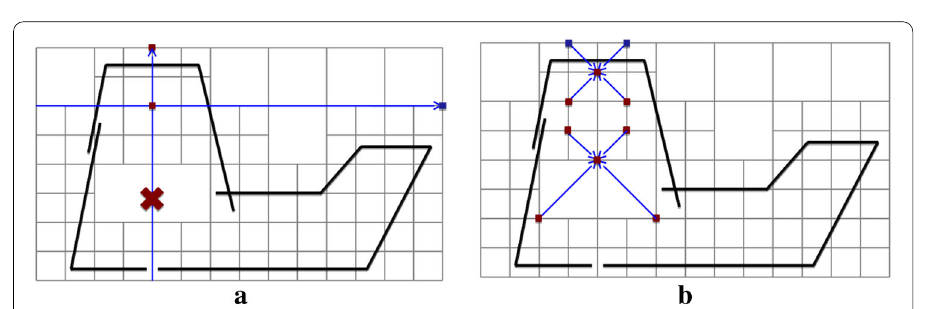
Fig. 31 Concept of voting: two rays vote whether a certain node is inside or outside. Then a decision is made based on the votes. Here, one ray is voting for outside and the other for inside. Note that in 3D, there is one more ray, so that a draw is not possible